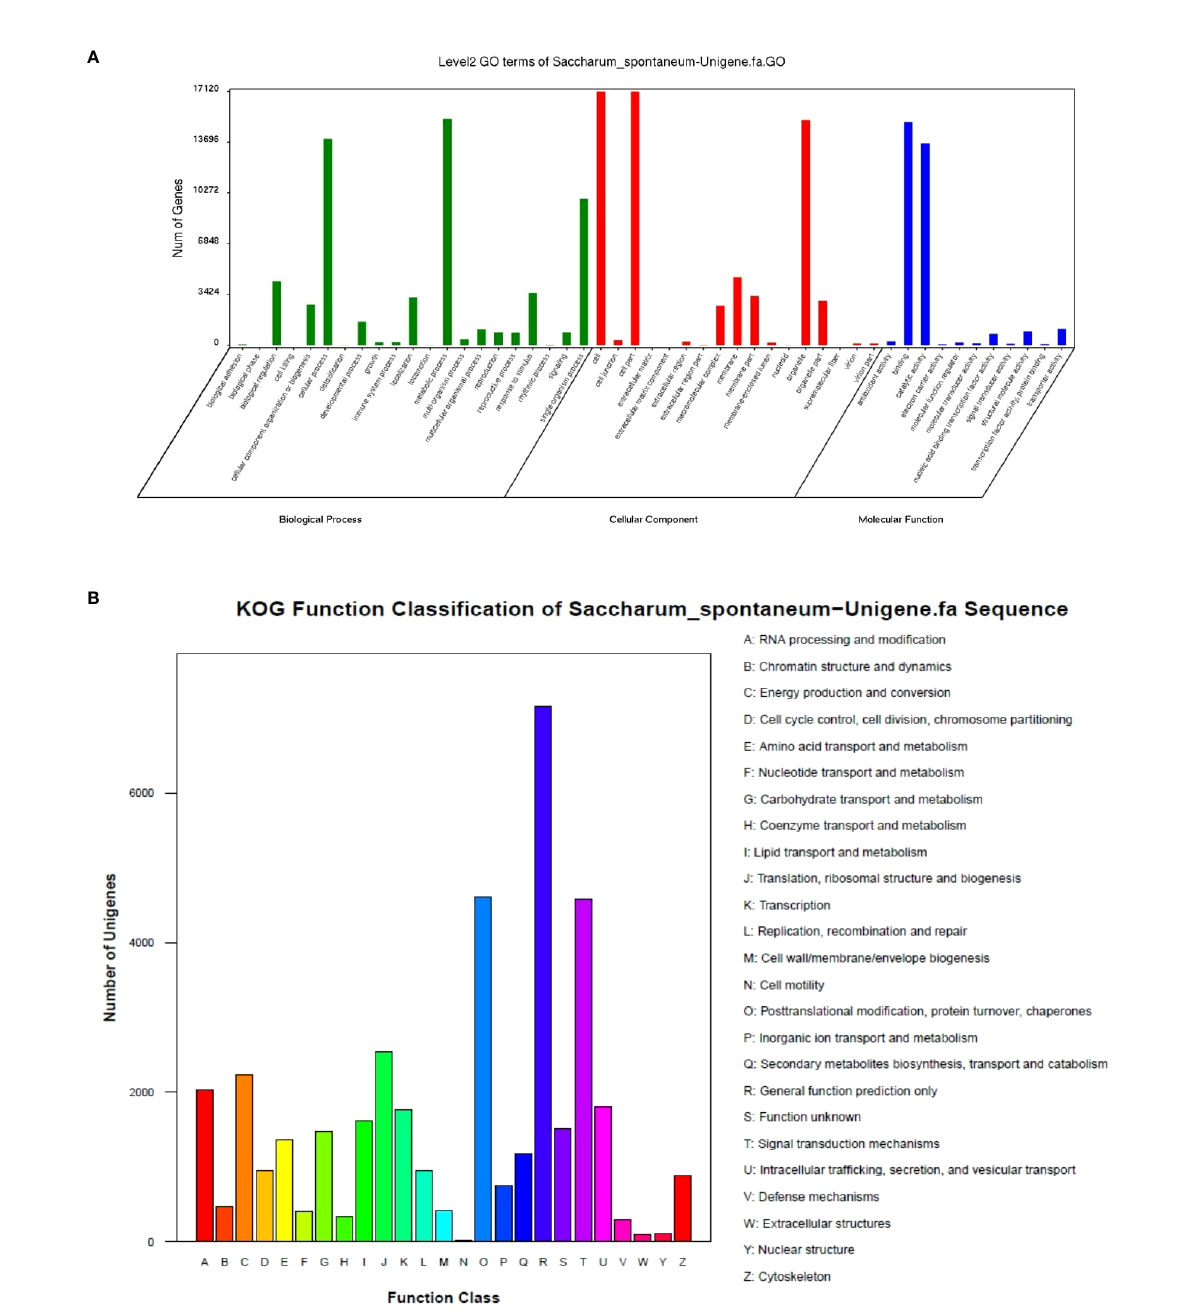
FIGURE 3 GO (A) and KOG (B) functions classi fi cation of expressed